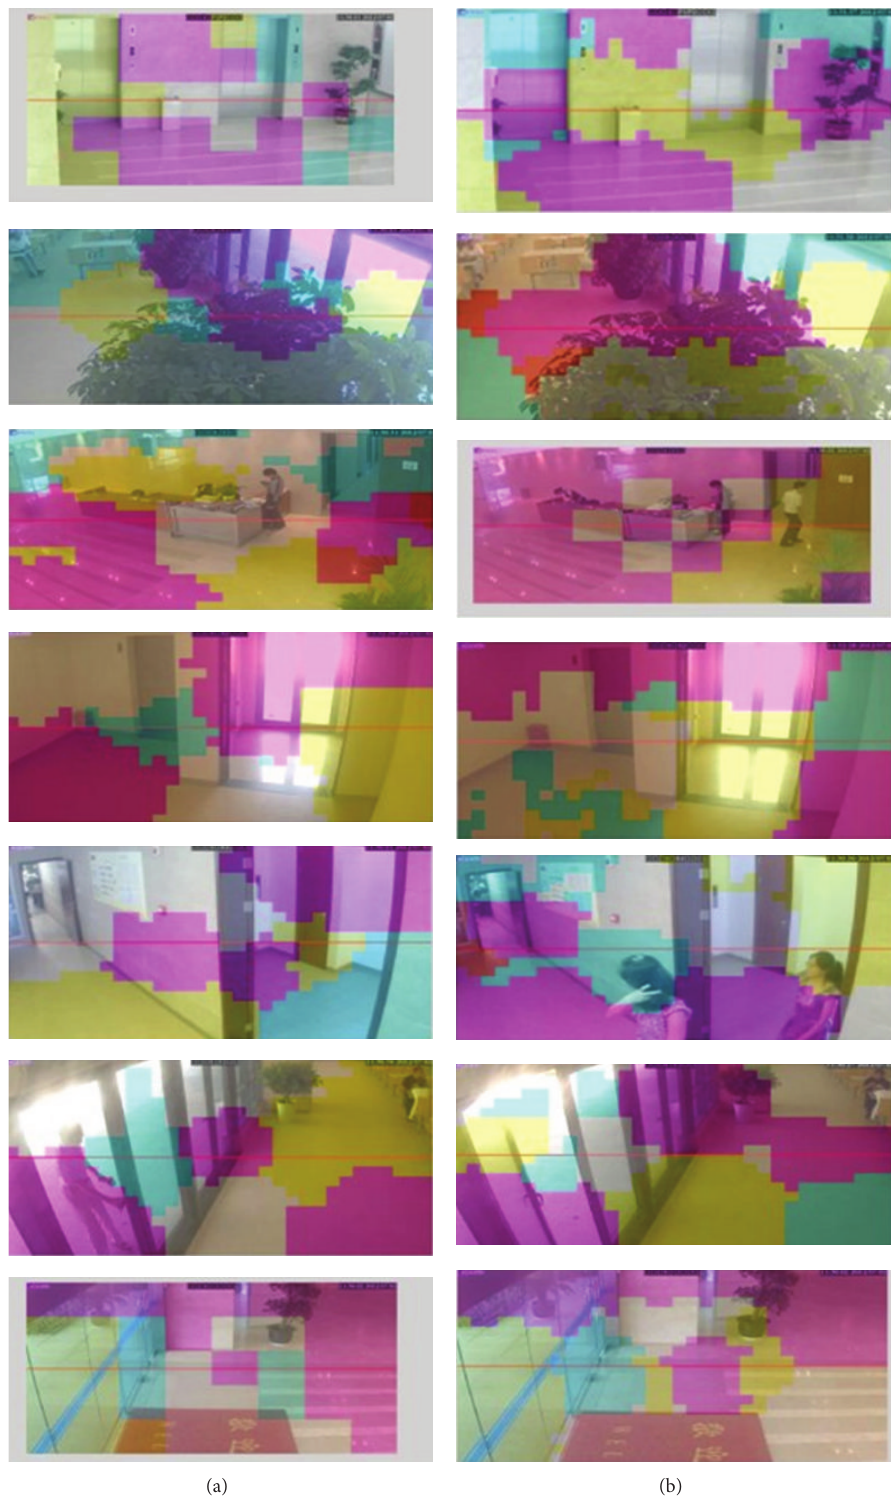
Figure 10: Experiment of activity-based scene decomposition, (a) experiment of activity-based scene decomposition based on HCOF, and (b) experiment of activity-based scene decomposition based on static and moving